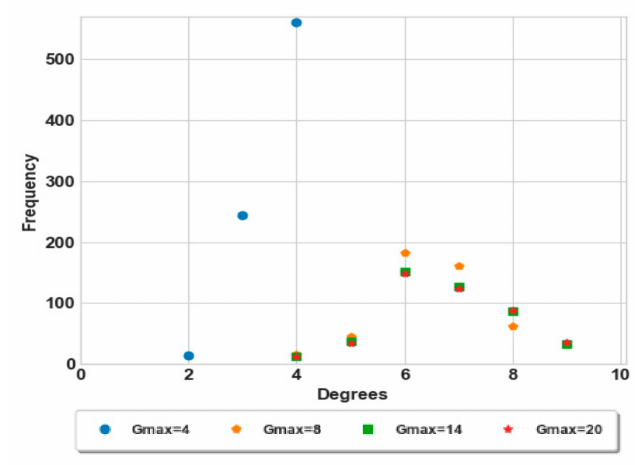
Figure 5. Degree distribution of groups.